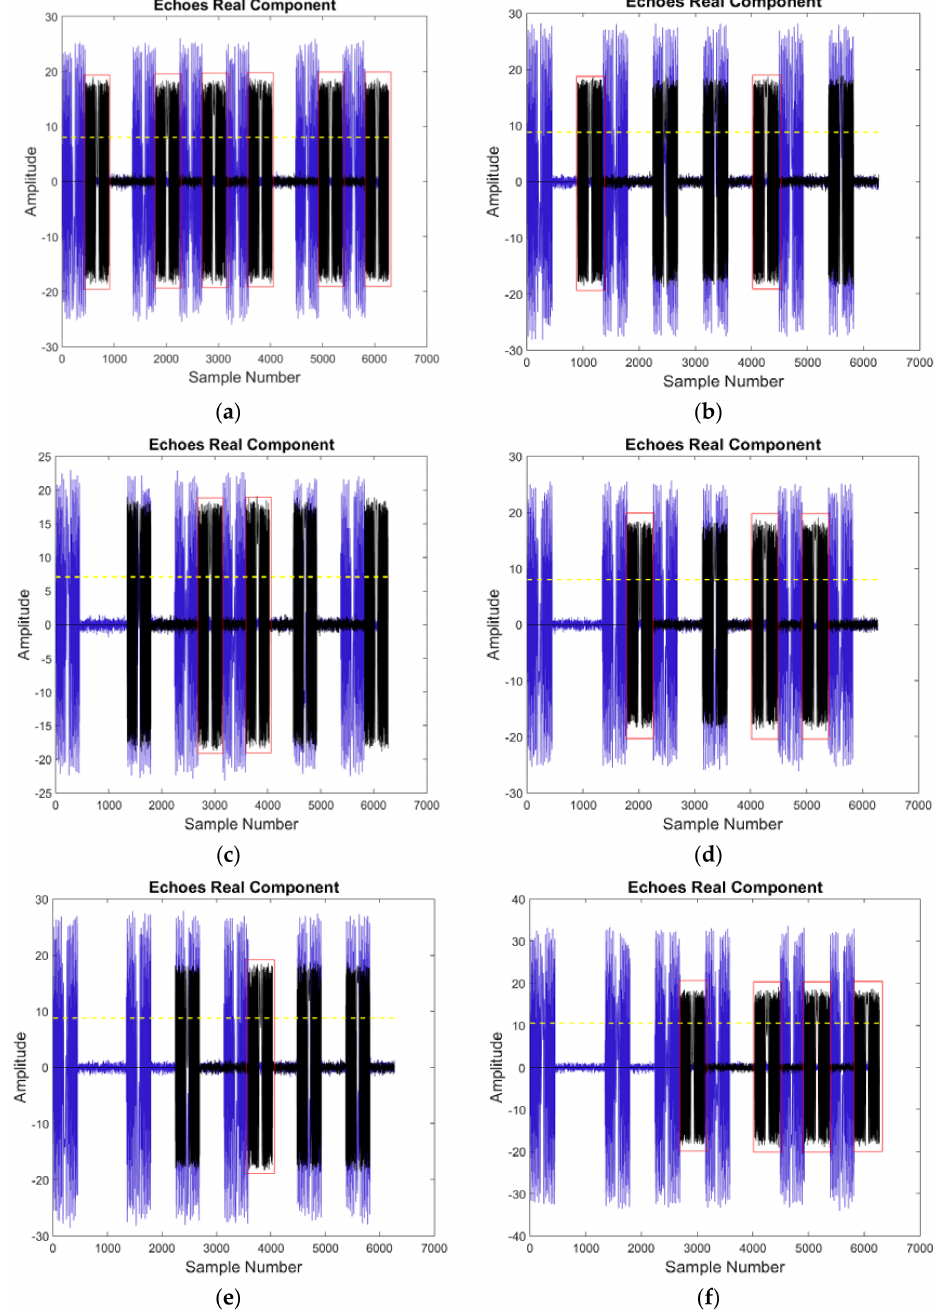
Figure 10. Simulation of beyond-PRT RDJ detection in one dimensional echo, for various time delays of ( a ) 1 PRT; ( b ) 2 PRTs, ( c ) 3 PRTs, ( d ) 4 PRTs, ( e ) 5 PRTs, ( f ) 6